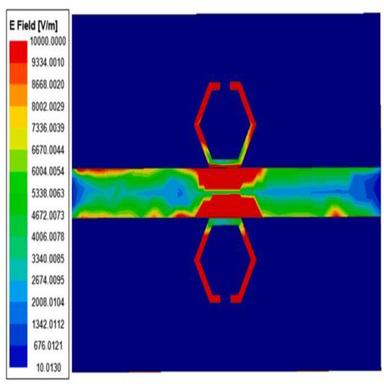
Distribution of electric field intensity of the HSRR sensor.